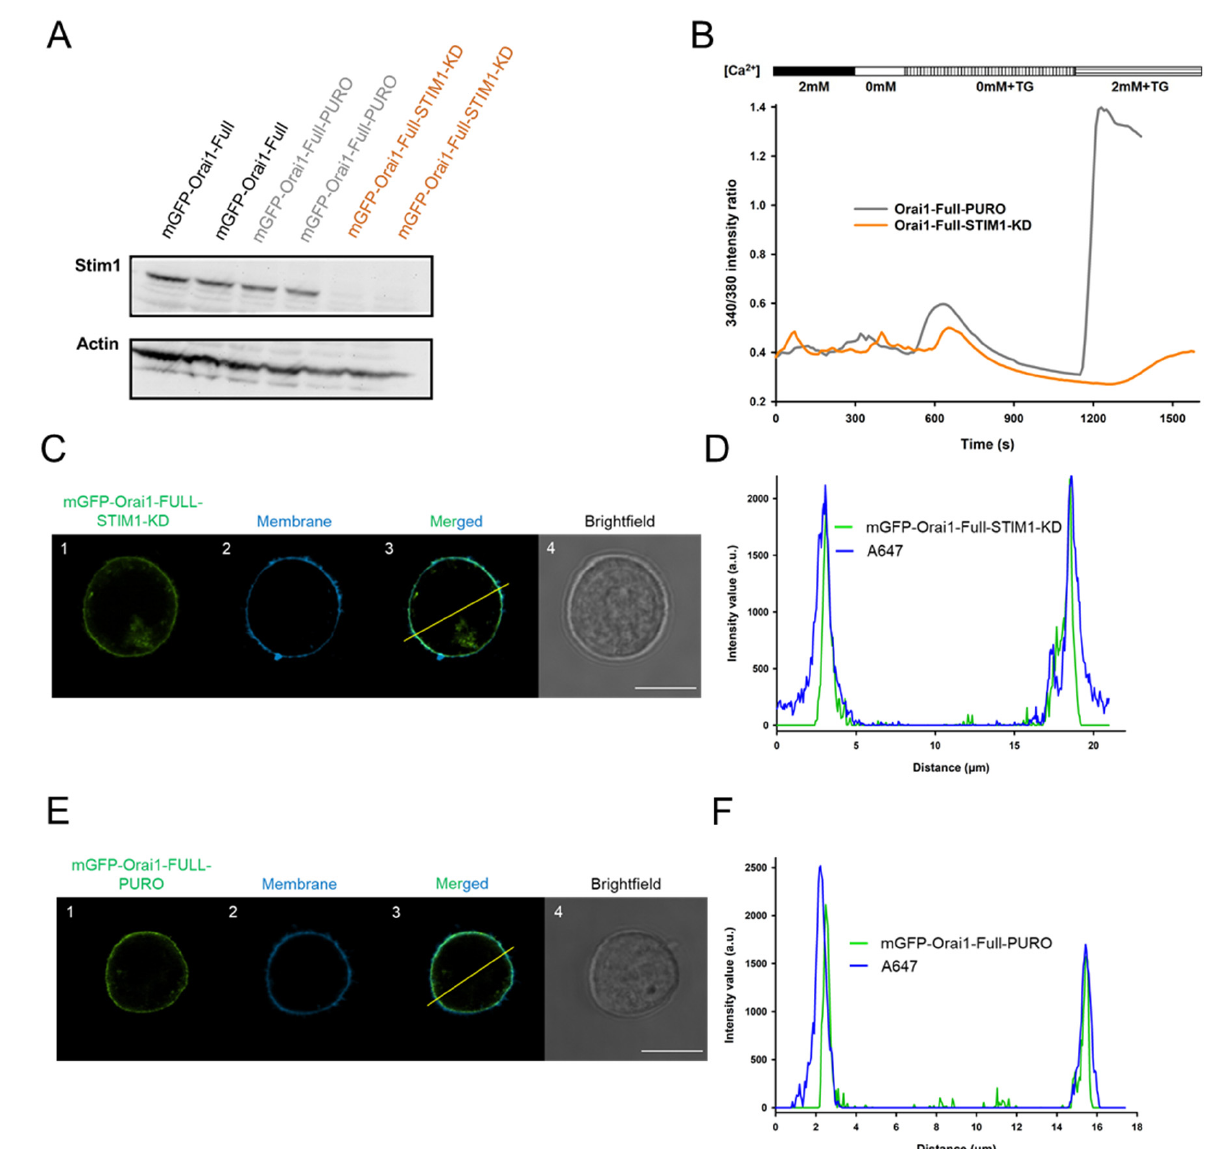
Figure 2. Knockdown of STIM1 in Jurkat cells expressing mGFP-Orai1-Full resulted in nonfunctional channels. ( A ) Western blot experiments of mGFP-Orai1-Full expressing Jurkat (black), mGFP-Orai1-Full-PURO ( grey ) and mGFP-Orai1-Full-STIM1-KD (orange) cells probed with a specific antibody against STIM1 (the expected size 85–88 kDa, each sample was loaded in duplicates). Actin antibody was used as an expression control with an approximate size of 42 kDa. (Knock-down efficiency was ca. 95%.) ( B ) Cytosolic Ca 2+ measurements using FURA-2 in mGFP-Orai1-Full-PURO cells stably expressing mGFP-Orai1-Full channels (grey) and in Jurkat cells missing the Orai1 activator STIM1 protein (mGFP-Orai1-Full-STIM1- KD) stably expressing mGFP-Orai1-Full channels (orange). Cytosolic Ca 2+ measurement based on the 340 nm/380 nm intensity ratio of FURA-2. The representative traces are the average of 18 cells (mGFP-Orai1-Full-PURO) and 8 cells (mGFP-Orai1-Full-STIM1-KD). ( C ) Typical confocal images of mGFP-Orai1-Full-STIM1-KD cells. ( C1 , E1 ) mGFP signal of Orai1-Full channel in STIM1-KD or PURO cells ( green ), ( C2 , E2 ) The Alexa Fluor™ 647 NHS Ester fluorescence of the plasma membrane (blue) in mGFP-Orai1-Full-STIM1-KD and mGFP-Orai1-Full-PURO cells. ( C3 , E3 ) The merge of green and blue channels in mGFP-Orai1-Full-STIM1-KD and mGFP-Orai1-Full-PURO cells, please note the overlapping of them. ( C4 , E4 ) Brightfield image of the mGFP-Orai1-Full channel expressing STIM1-KD or PURO cells in Ca-Cc or Ea-Ec. Scale bar is 10 µ m. ( D , F ) The pixel-by-pixel intensity profile analysis of the mGFP-Orai1-Full-STIM1-KD and mGFP-Orai1-Full-PURO cell along the line indicated in the merged image ( C3 , E3 ): green: mGFP-Orai1, blue: membrane, Alexa-647 NHS